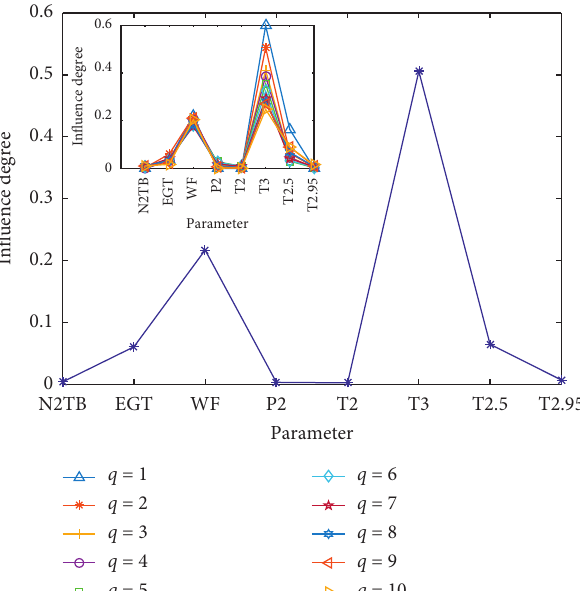
Figure 9: The influence degree of the first-order detrended partial cross-correlation in aeroengine system and the influence degree of the first-order multifractal detrended partial cross-correlation coefficient in aeroengine system (the upper left figure).